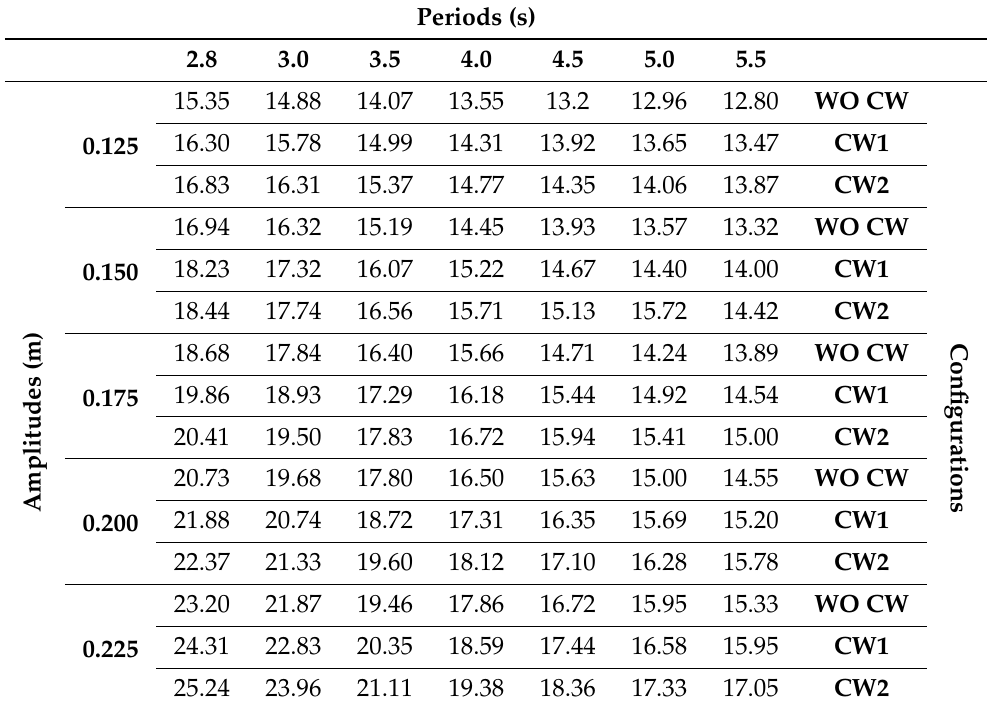
Table 8. Maximum fairlead tension in N for all the test matrix and configurations. Notation WO CW, CW1 , and CW2 denotes mooring line without clumped weight, mooring line with clumped weight (Configuration 1) and mooring line with clumped weight (Configuration 2), respectively.